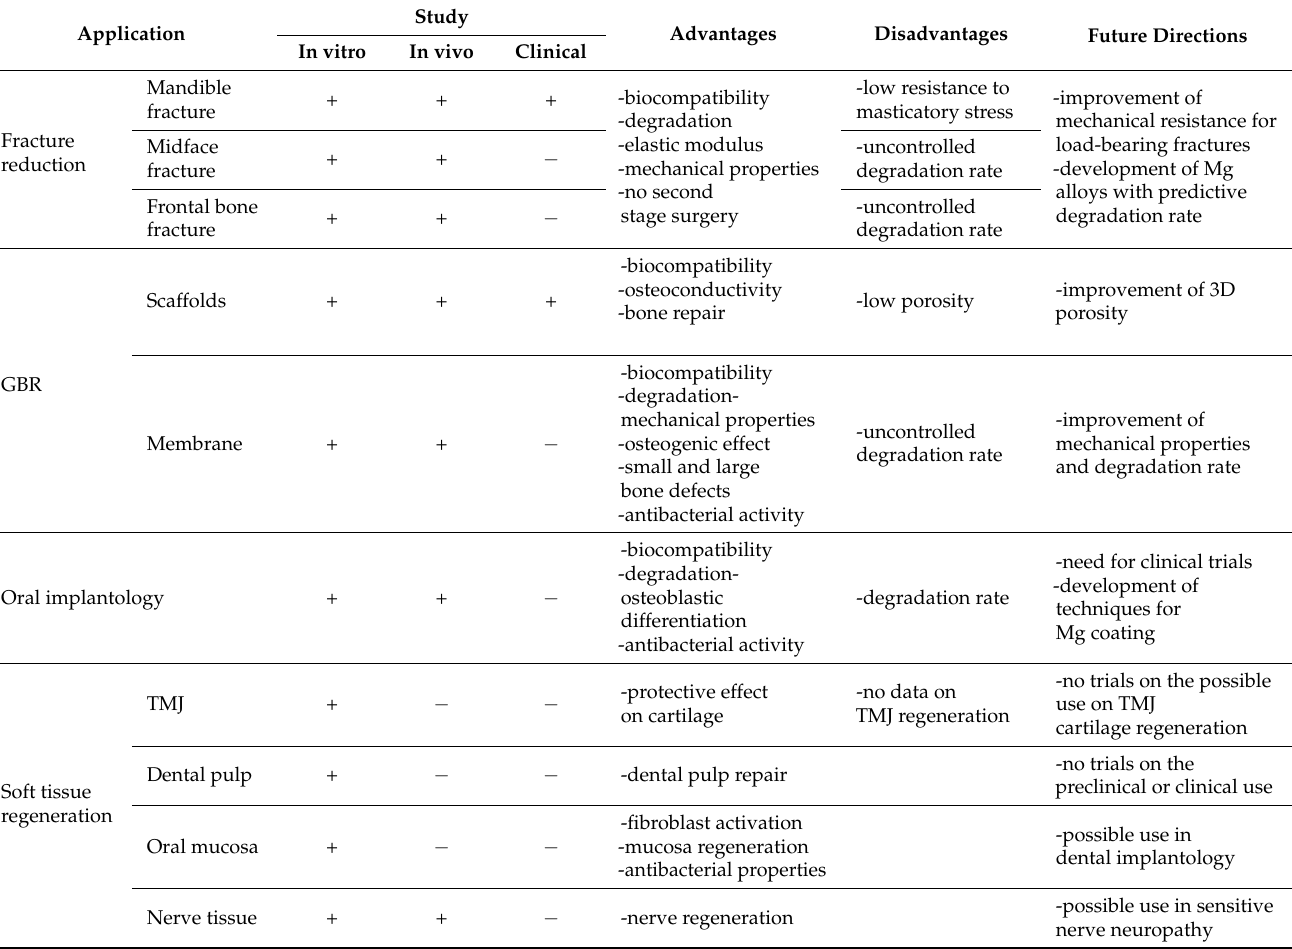
Table 3. Overview of applications of magnesium (Mg)-based materials in reconstructive oral and maxillofacial